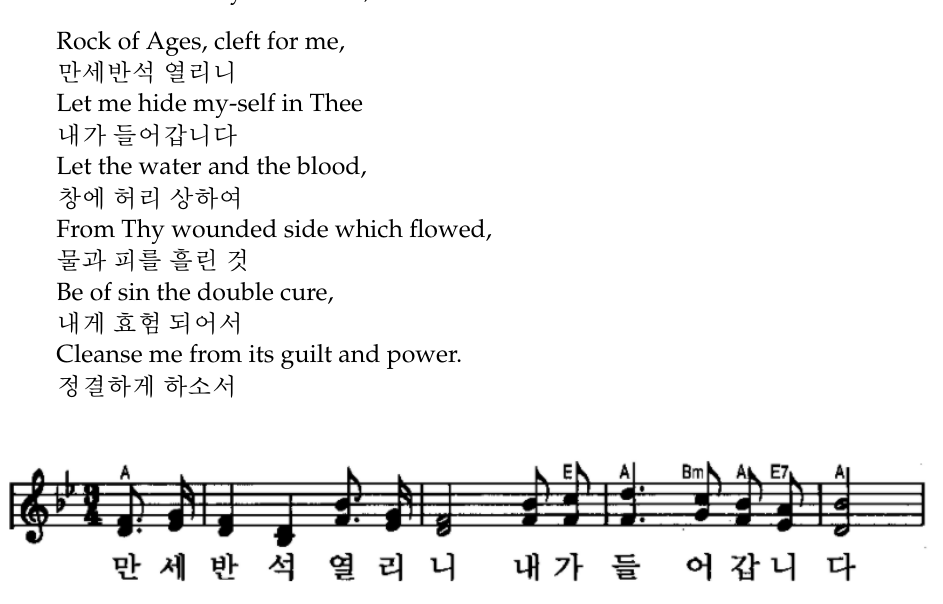
Figure 1. Korean score of “Rock of Ages, Cleft for Me” (The Hymn Society of Korea 1983). The Korean lyrics in the score mean, “When the rock of ages is opened, I enter the cleft”.